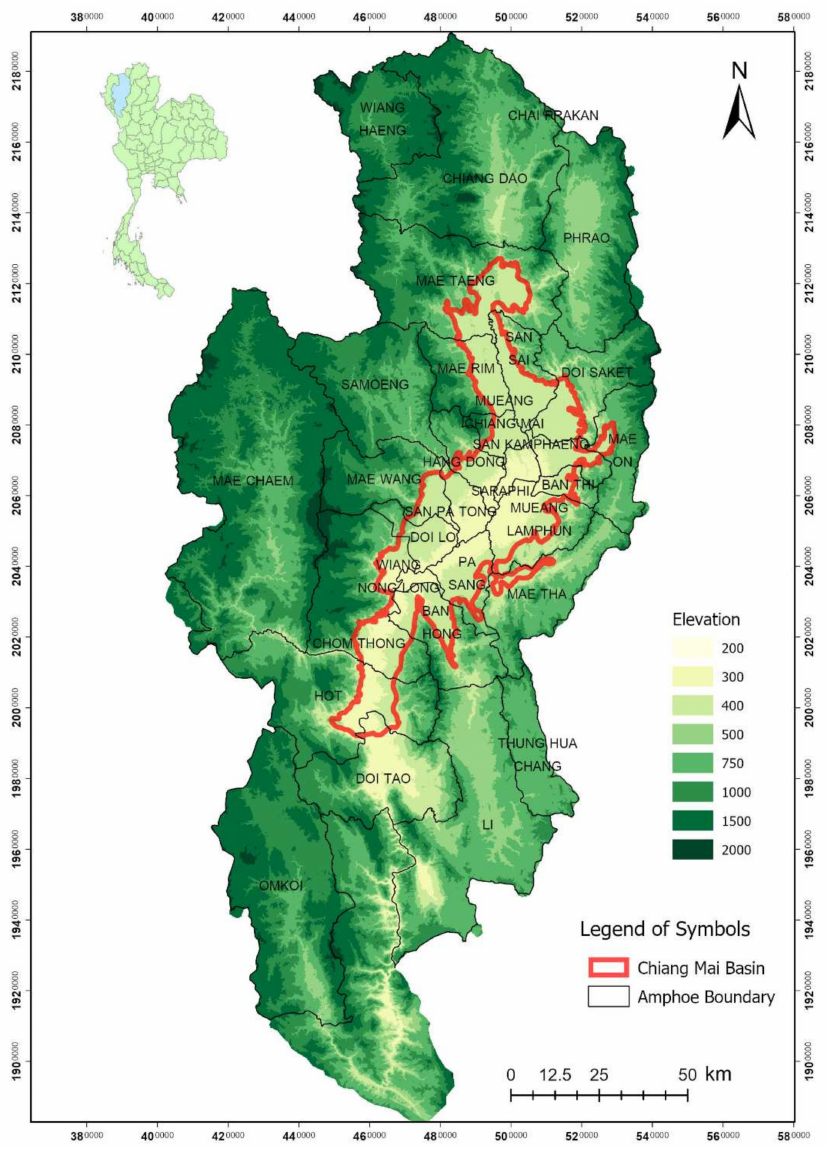
Figure 1. Digital elevation map and boundary of unconsolidated aquifers Chiang Mai basin (~2800 km 2